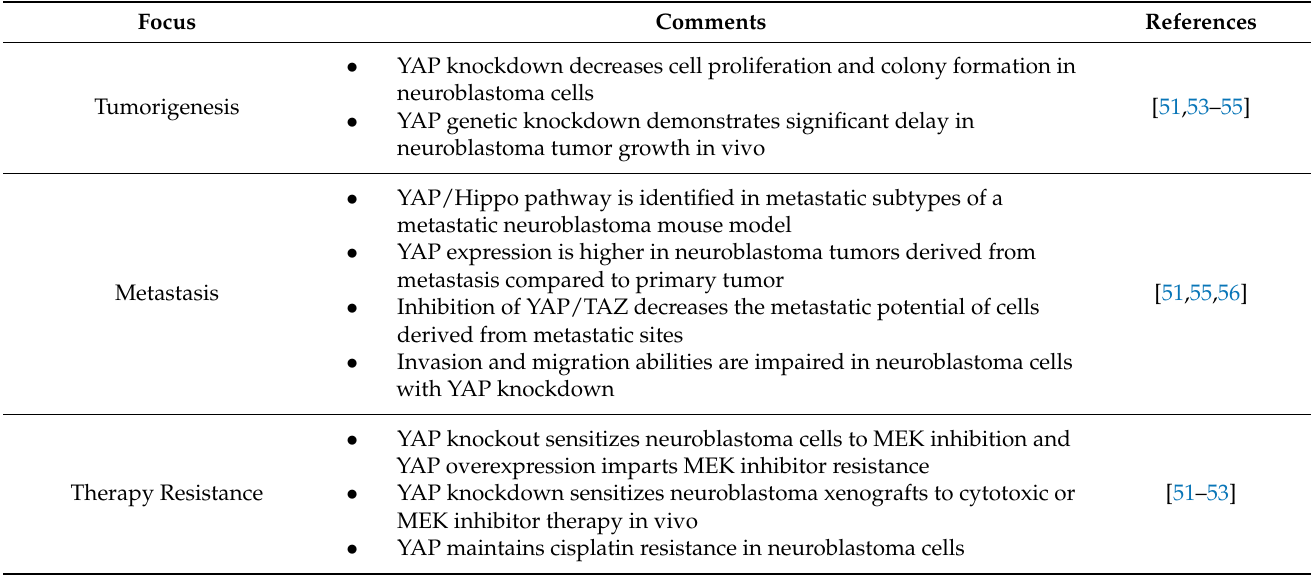
Figure 1. YAP/Hippo Signaling Pathway. Adapted from “Hippo Pathway in Mammals” by BioRender.com (2021). Retrieved from https://app.biorender.com/biorender-templates (accessed on 8 September 2021). Table 1. YAP in neuroblastoma: summary of the